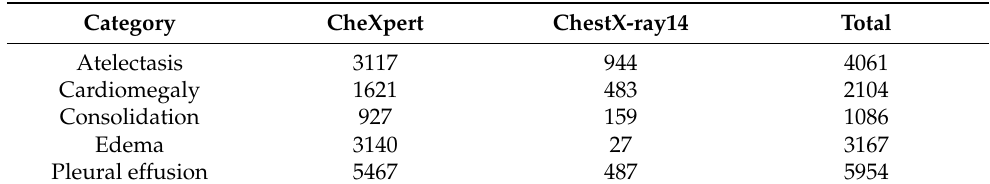
Table 1. Image quantities used to generate the database used for this work.